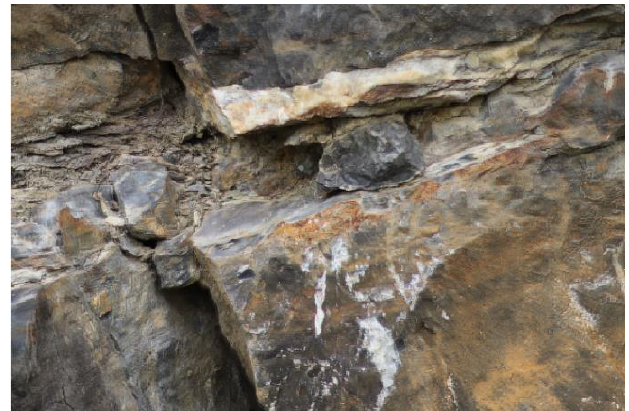
Figure 12. A 2D reconstruction of the limestone image by the optical cuts used in Figure 11. The software was written by the first author. Taken from [45].